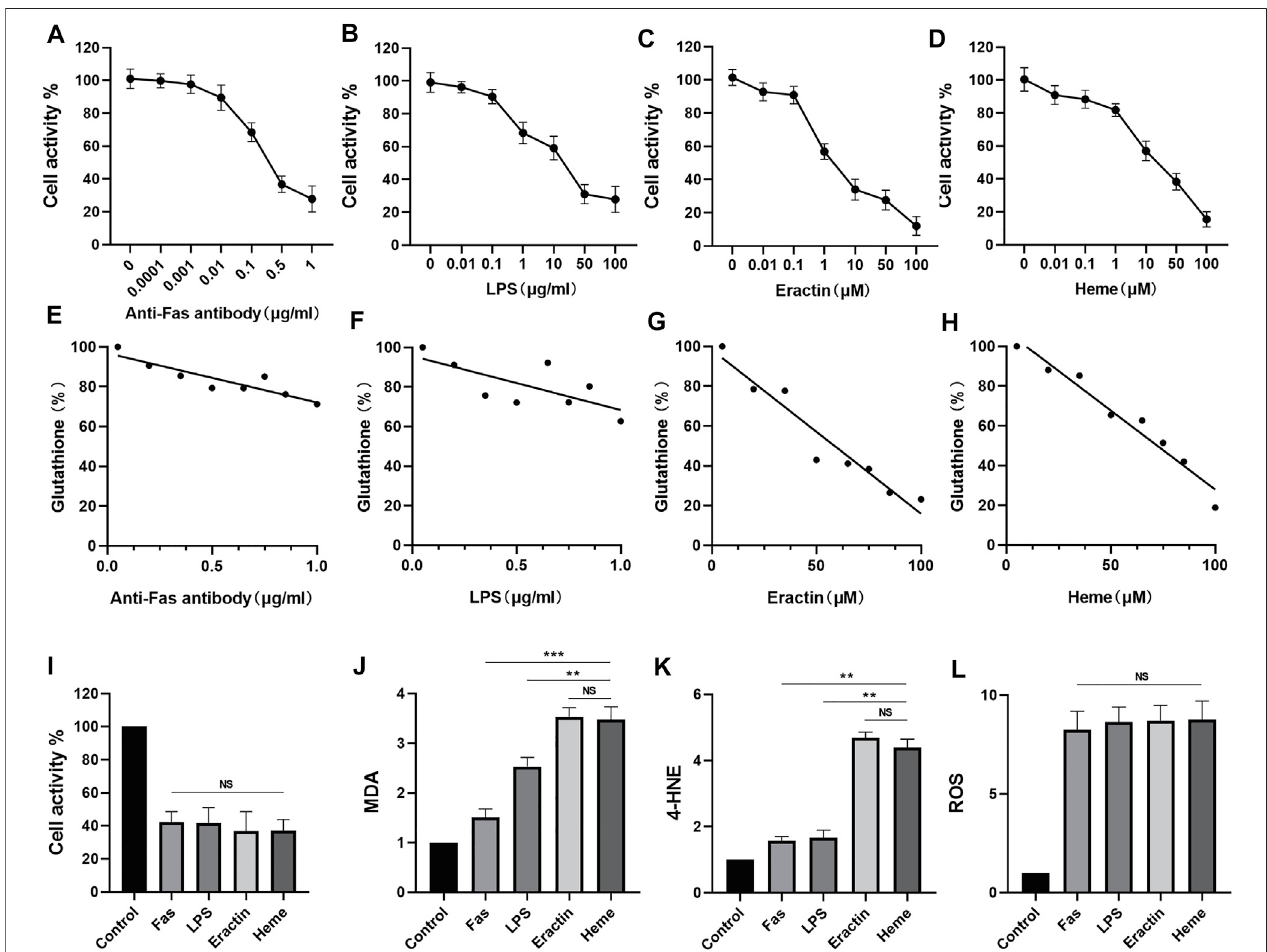
FIGURE1| Comparison oftheeffectsoffourinducersofneurondeathontheexpressionofbarbedwirerelatedmetabolitesandrelatedproteins. (A – D) Theneural activity of the neurons treated with anti-Fas, LPS, Erastin and Heme at different concentrations for 6 h was determined, and the cellular activity of the neurons was evaluated by CCK-8 analysis. (E – H) The glutathione (GSH) levels of neurons treated with anti-Fas, LPS, Erastin and Heme at different concentrations for 6 h were determined. (I – L) Based on cck-8 analysis, neurons were treated with anti-fas antibody (0.5 μ g/ml), LPS (50 μ g/ml), Erastin (50 μ M), and Heme (50 μ M) for 6 h, then the levels of MDA, 4-hne, and glutathione were determined. (M , N) The content of Gpx4 in cell samples of each group was analyzed by WB. Data are shown as the means± SDof n =3samples/group, and at leastthree independentexperiments were performed. Statistical analyses were conducted usingtwo-wayANOVA followed by the Newman-Keuls multiple-comparison post hoc test. * p < 0.01, ** p < 0.01, *** p <